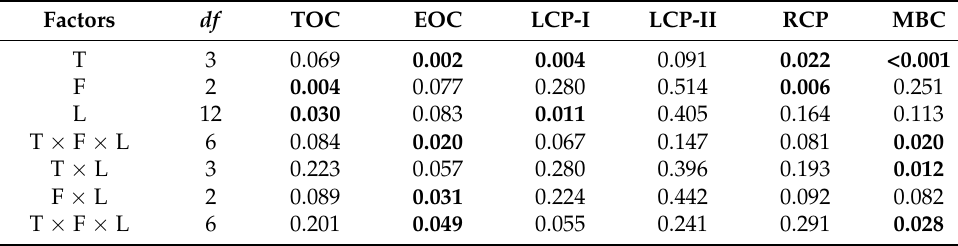
Figure 4. Structural equation model (SEM) describes multivariate effects of environmental factors and SOC pools on the soil total organic carbon (TOC). FTC, number of freeze-thaw cycles; MBC, microbial biomass carbon; EOC, easily oxidizable carbon; LCP, labile carbon pool; χ 2 , chi-square; P , probability level; df, degrees of freedom; GFI, goodness of fit index; CFI, comparative fit index. Blue and red arrows indicate positive and negative relationships, respectively. Numbers next to arrows represent standardized regression weights (** p < 0.01, *** p < 0.001), the magnitudes of which are proportional to the thickness of the arrows. R 2 values alongside each variable represent the estimates of multiple correlations, interpreted as proportion of variance explained for a given response vari- able. Table 4. Results of three-way RANOVA showing the p -values concerning the effects of sampling time (T), forest type (F), litter treatment (L), and their interactions on soil organic carbon fractions.